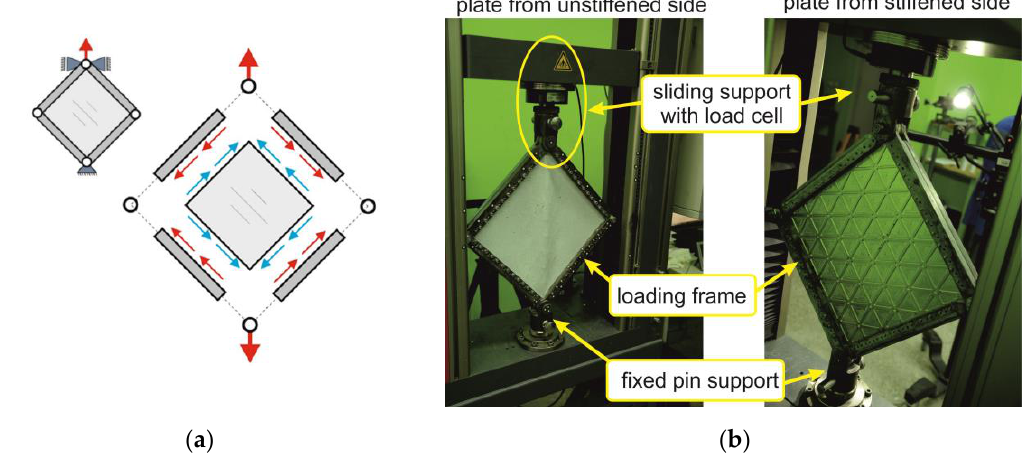
Figure 4. Experimental setup: ( a ) loading conditions, ( b ) plate mounted in the test area of the strength